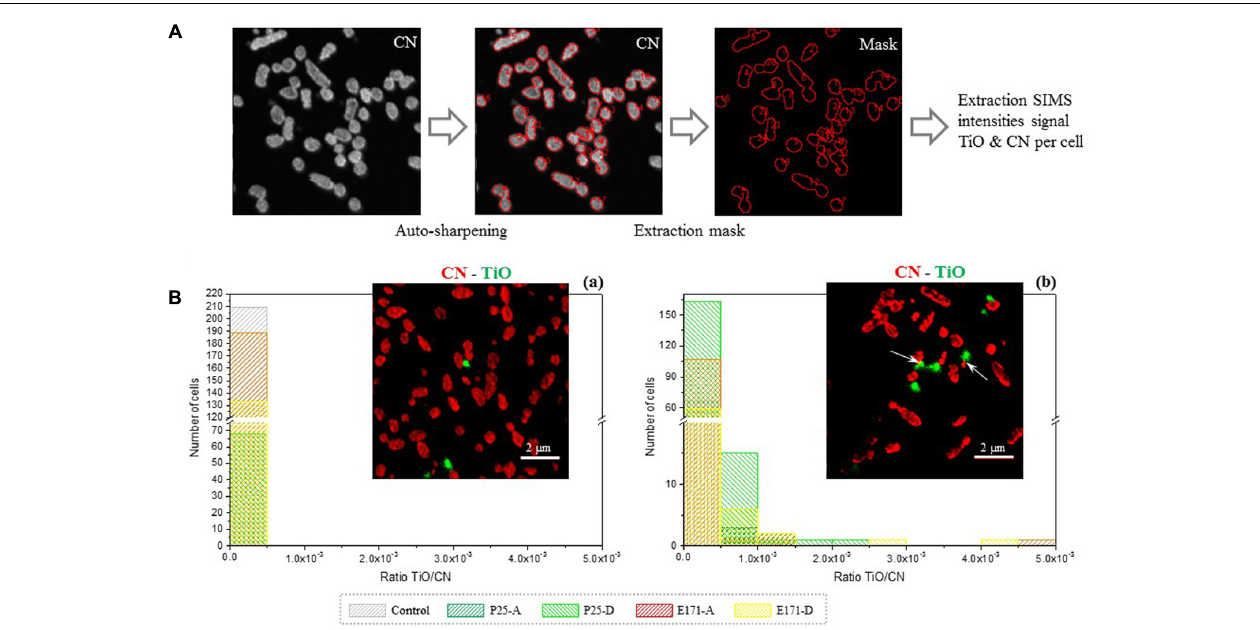
FIGURE 6 | High-resolution nano-secondary ion mass spectrometry (Nano-SIMS) chemical imaging of bacterial cells after TiO 2 exposure. (A) Methodology for the extraction of the SIMS intensities for each individual cell. From the SIMS CN image acquisition, by auto sharpening, each cell is individualized. The mask obtained is applied on image acquisition, allowing to extract the total SIMS intensities for each cell and for all the ions recorded; (B) Distribution of the TiO signal normalized by the CN signal among the bacterial population for (a) L. lactis IBB477 and (b) E. coli K12 MG1655 bacterial cells non-exposed (black hatched) and exposed to P25-A (dark green hatched), P25-D (light green hatched), E171-A (red hatched) or E171-D (yellow hatched). For each species a representative image is given with cells (in red) exposed to E171-A (in green) at 320 µ g/mL. White arrows indicate internalized TiO 2 particles. Samples were fixed, embedded and ultra-sectioned. Scale bar corresponds to 2 µ